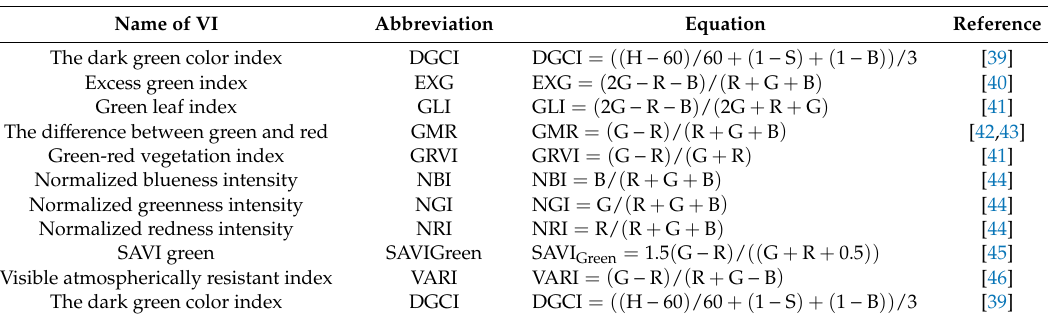
Table 4. Color-based VIs used in this